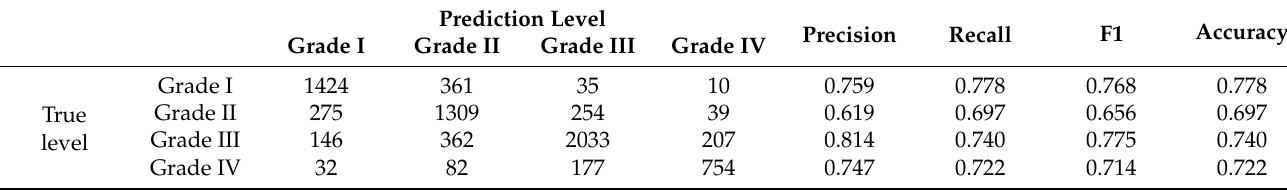
Table 4. Improved model evaluation index based on transformer.